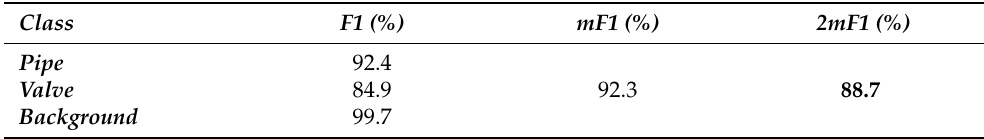
Table 1. DGCNN pixel-level metrics on T BASE test set.